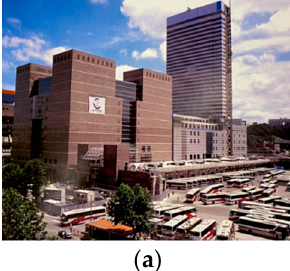
Figure 1. Front view of the terminal complex buildings. ( a ) Terminal Complex A. ( b ) Terminal Complex B. ( c ) Terminal Complex C.